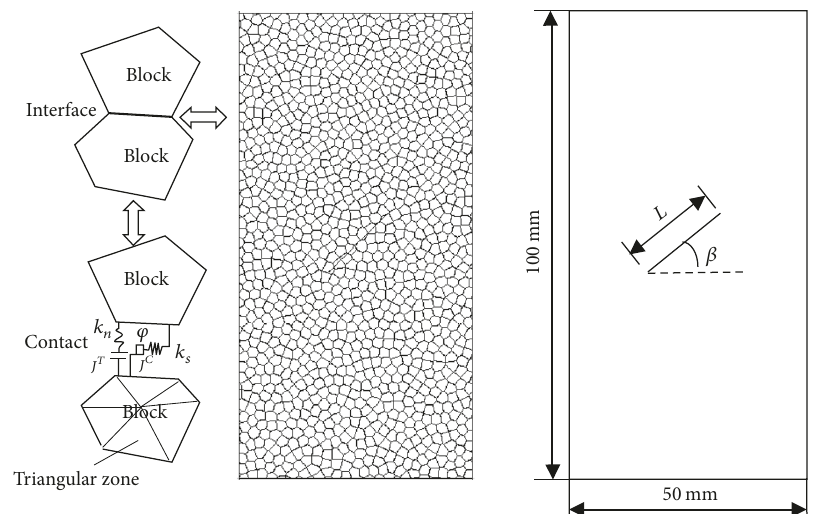
Figure 2: The contact behaviour in UDEC model.